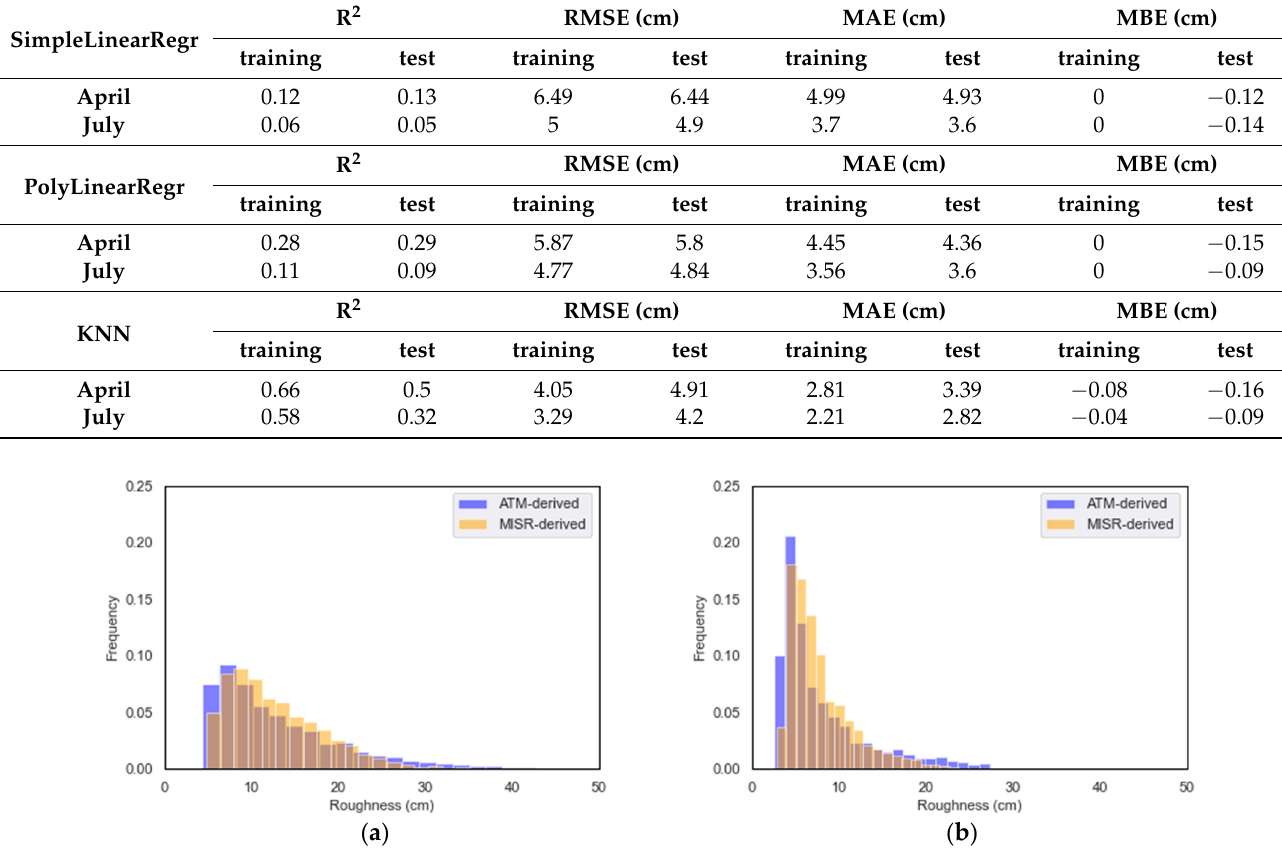
Figure 3. Q-Q plots for the April and July 2016 datasets ( a and b ) show the error distribution of MISR-estimated roughness for ( a ) April and ( b ) July 2016. Both Q-Q plots show deviation from the straight line, suggesting that sample residual quantiles are quite different from the theoretical quantiles and are not normally distrib- uted. Also, both plots are skewed at their tails, but the July residual distribution is more skewed at both tails compared to the April distribution. The Q-Q plots for April (Figure 3a) show that residual points fall along the best-fit line in the middle of the graph, but the differences increase on both ends of the distribution of residuals. This indicates that resid- uals have more extreme values at both ends of the residual distribution. The Q-Q plots for